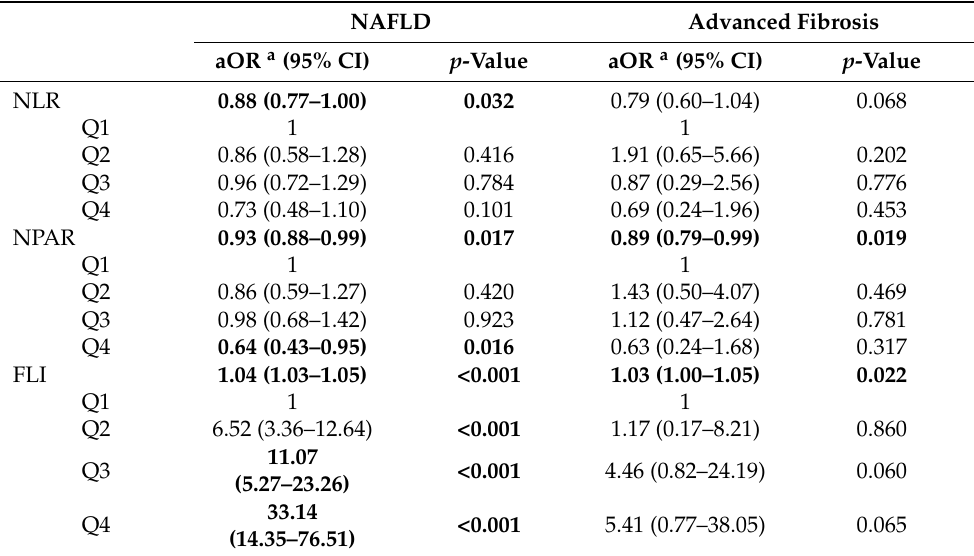
Table 2. Multivariable regression analysis of associations between NLR, NPAR, FLI, and presence of NAFLD and advanced liver fibrosis.